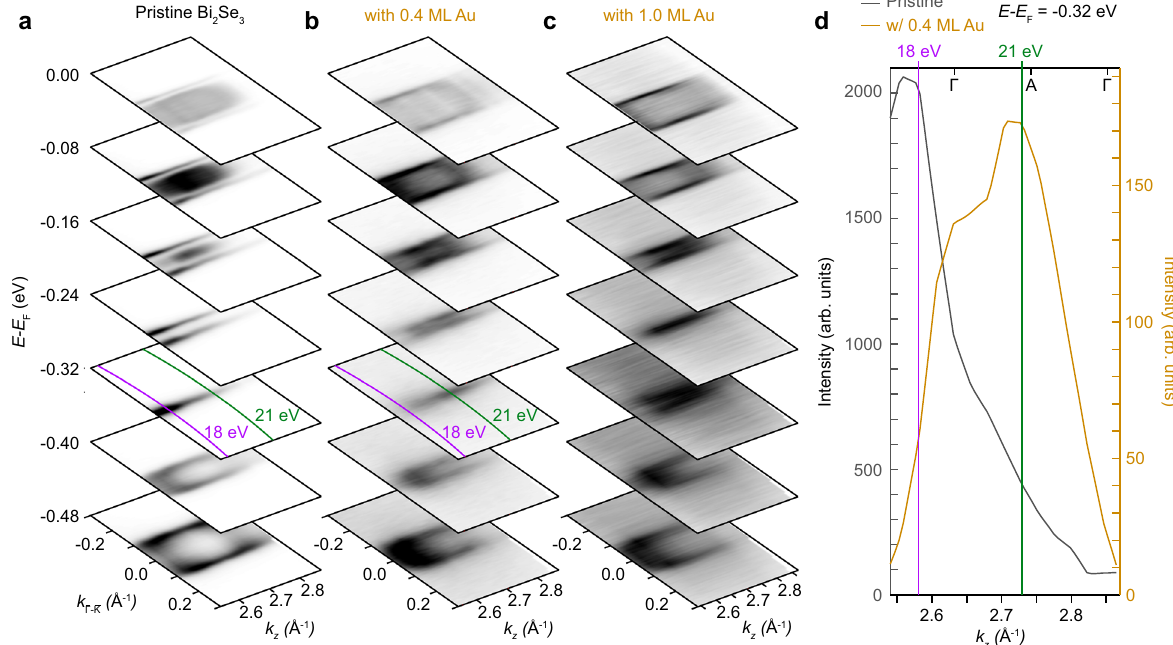
Fig. 3 Photon-energy dependence of photoemission matrix elements. a – c Constant energy k x – k z contours for pristine and Au-dosed Bi 2 Se 3 . The green and purple lines in select contours highlight the k-vectors corresponding to h ν = 18 and 21 eV respectively, with which all dispersions shown in Fig. 2 are taken. The displayed k z range spans over 1.5 complete Brillouin zones. b, c Equivalent dataset following 0.4 ( b ) and 1.0 ( c ) monolayers (ML) of Au deposition. d Out-of-plane ( k z ) momentum-distribution curve for k x = 0 Å − 1 and E − E F = − 0.32 eV highlighting the suppression of Dirac point intensity for low photon energies following 0.4 ML Au deposition. High symmetry points, along with the k z vectors corresponding to 18 and 21 eV photons, are